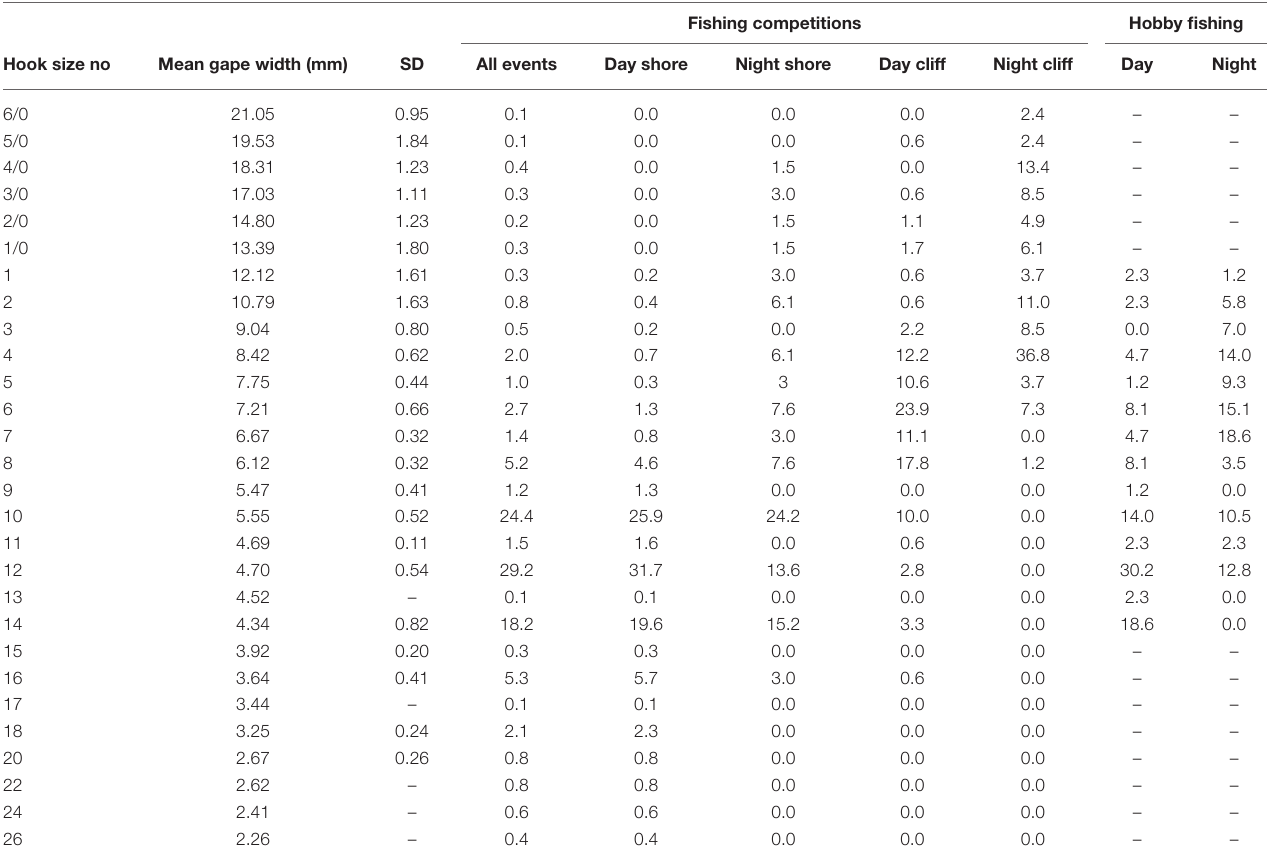
TABLE 2 | Mean width of hooks frequently used by anglers and their preference by sport fishing and hobby